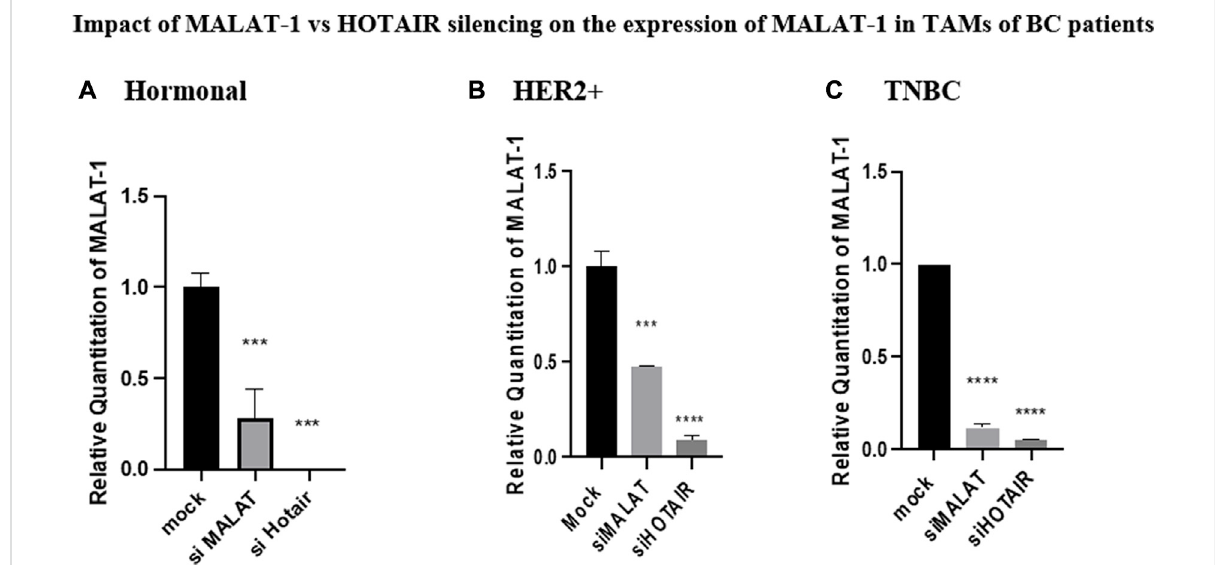
FIGURE 4 Impact of MALAT1 vs. HOTAIR silencing on the expression of MALAT1 in TAMs of (A) hormonal, (B) HER2+, and (C) TNBC. MALAT1 mRNA levels were measured using qRT-PCR and were normalized to β -actin (endogenous control). The results showed that HOTAIR and MALAT1 silencing resulted in a statistically signi fi cant downregulation in MALAT1 expression in the hormonal, HER2+, and TNBC subtypes when compared to the untransfected controls (mocks) of the three subtypes with more signi fi cant downregulation of MALAT1 upon silencing of HOTAIR than that observed upon silencing of MALAT1 itself. One-way Anova followed by Dunette ’ s test of multiple comparison was used for the purpose of comparison between more than two different studied groups. **** = p < 0.0001, *** = p < 0.001, ** = p < 0.01, * = p < 0.05, and ns = statistically not signi fi cant.